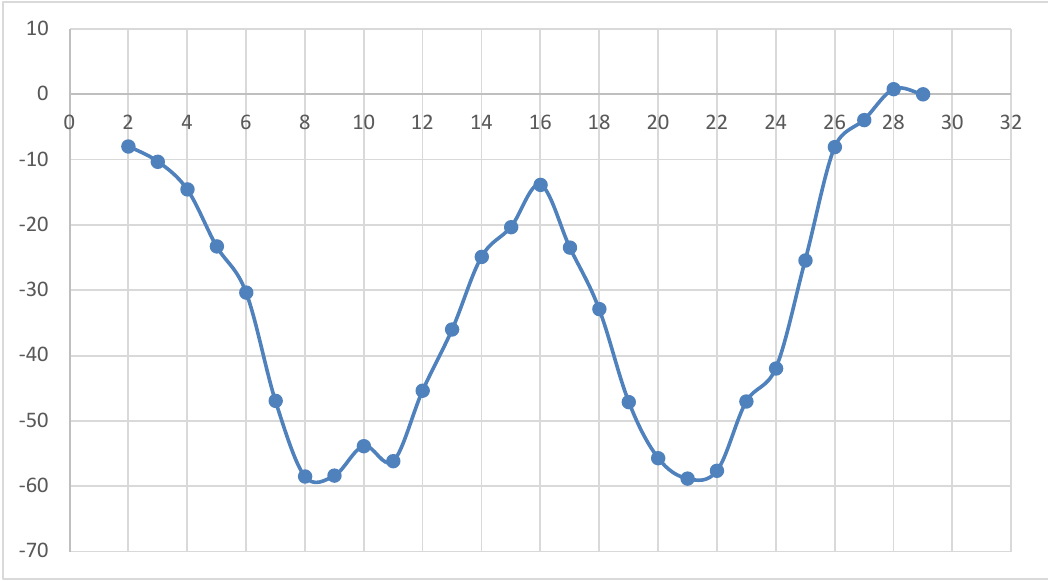
Figure 12. CUSUM chart of monthly average data between January 2014 and June 2016. The CUSUM chart is used to monitor the mean of a process based on samples taken from the process at given time points (hours, shifts, days, weeks, months, etc.). The meas-